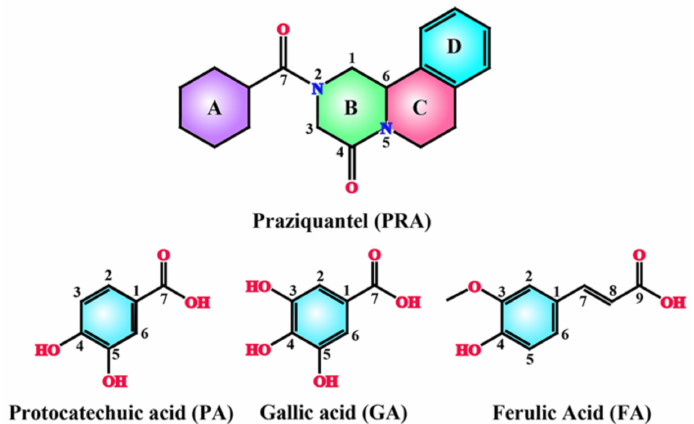
Figure 11. Molecular structures of API and CCFs. The rings with different colors are labeled to assist with the crystal structure